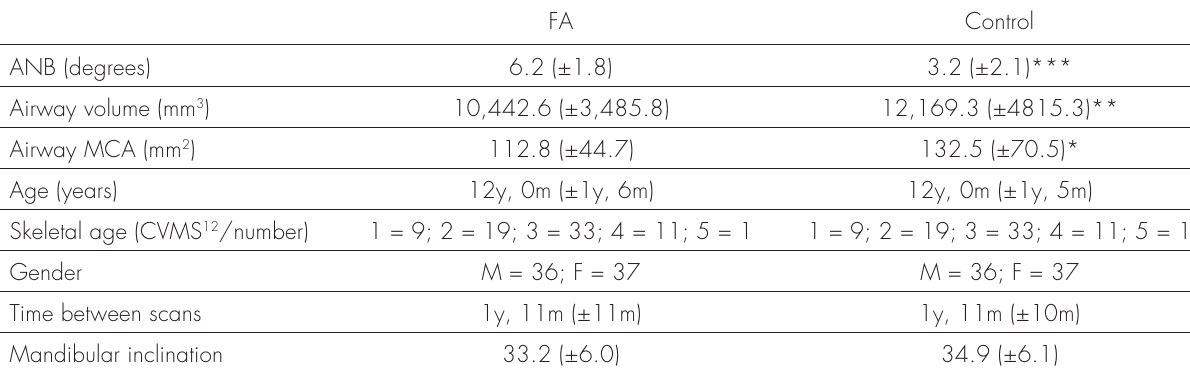
Table II. Differences between the two groups before